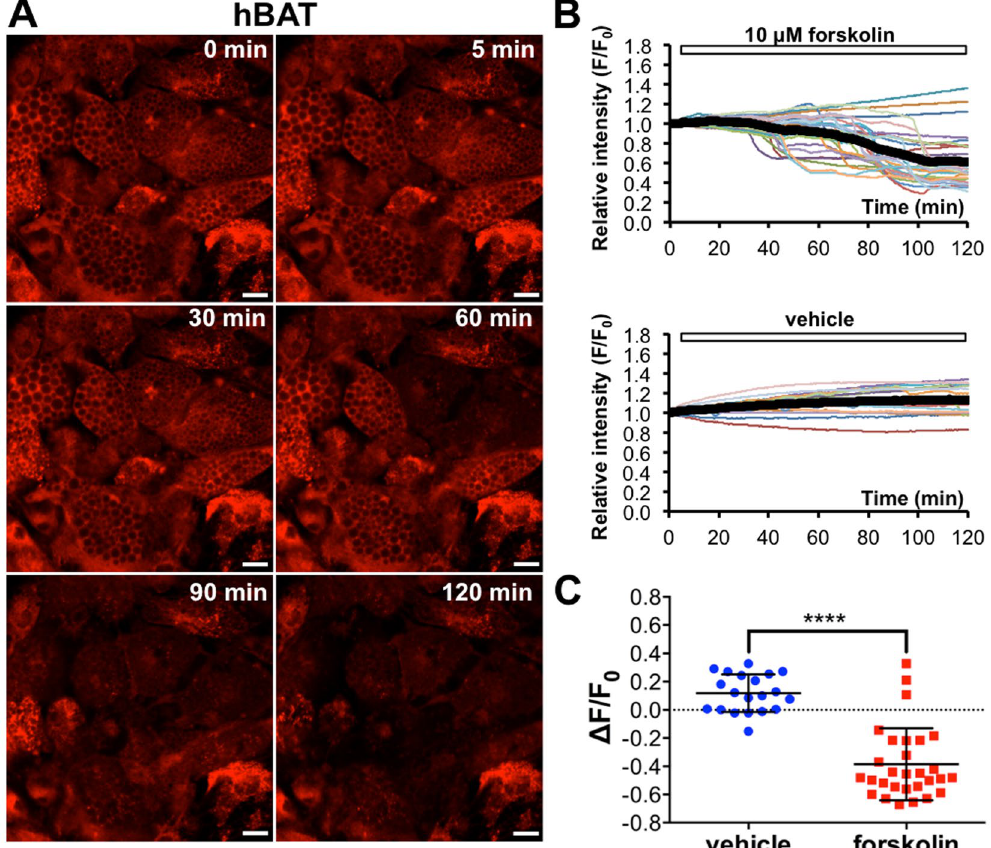
fluorescence intensity, suggesting a robust increase in temperature. Scale bar: 20 μ m. For time-lapse videos, see Supplementary Video 5. ( B ) Quantitative analysis of ERthermAC fluorescence intensity in human BAs after forskolin and vehicle stimulation: individual cells exhibit a rapid decline in relative intensity after forskolin stimulation. The reductions in fluorescence intensity occur at different time points in individual cells. In contrast, vehicle stimulation does not affect ERthermAC intensity. Thick black curves correspond to the mean relative intensity in each group. ( C ) Scatter plot of ERthermAC relative intensity change shows a significant difference between forskolin and vehicle stimulated brown adipocytes. Bars show mean ± SD. hBAT vehicle: n = 20 cells from 3 cultures; hBAT forskolin: n = 29 cells from 3